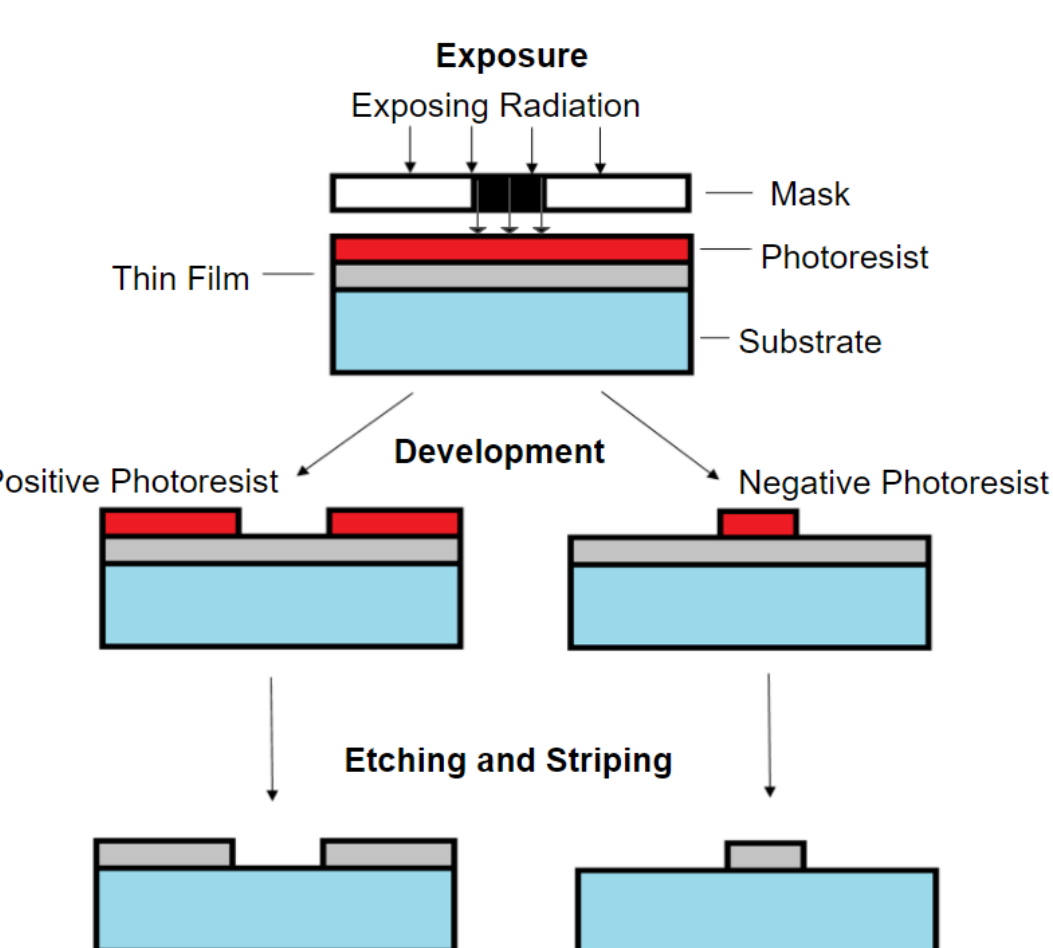
Figure 2. Process of photolithography. Initially, the film of photoresist is coated on the substrate, and photoradiation is used to cure a region coated by the photoresist (the curved region is removed with a positive photoresist remover and the uncured region is removed with a negative photoresist remover).